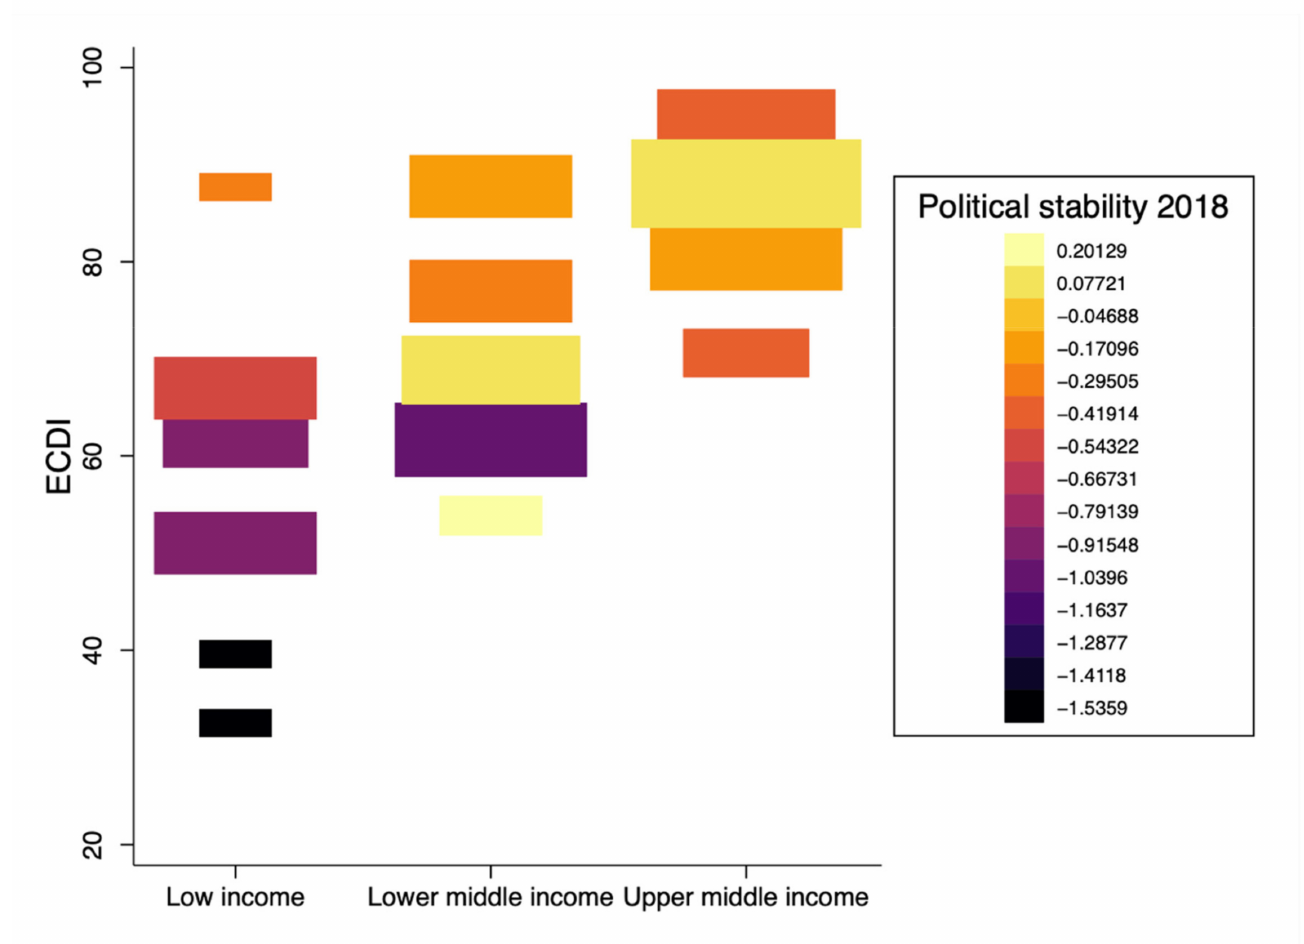
Figure 3. Early Childhood Development Index (ECDI) levels by income category and political stability ( N = 68 countries). Note: Bigger squares indicate a higher proportion of data points. Y-axis displays country classification by income groups according to the World